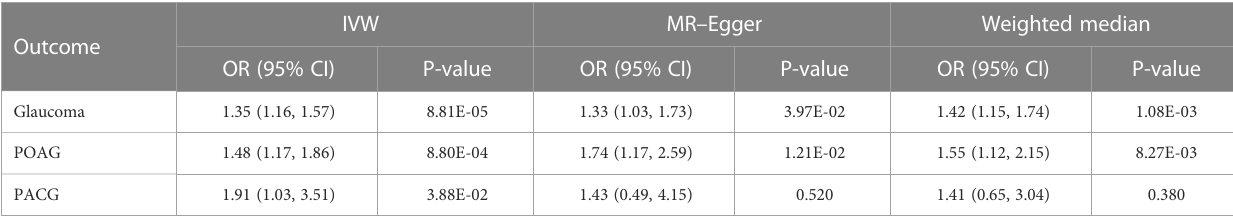
MR, Mendelian randomization; AS, ankylosing spondylitis; POAG, primary open-angle glaucoma; PACG, primary angle-closure